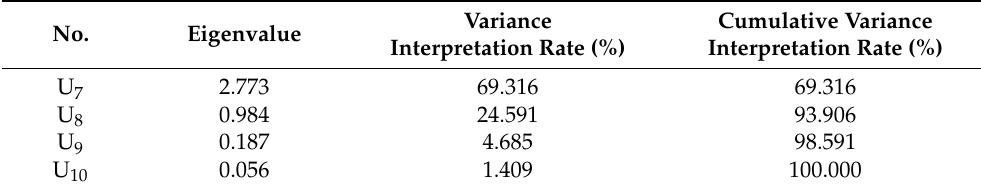
Table 7. Principal component variance interpretation of water and fertilizer use efficiency under each treatment.